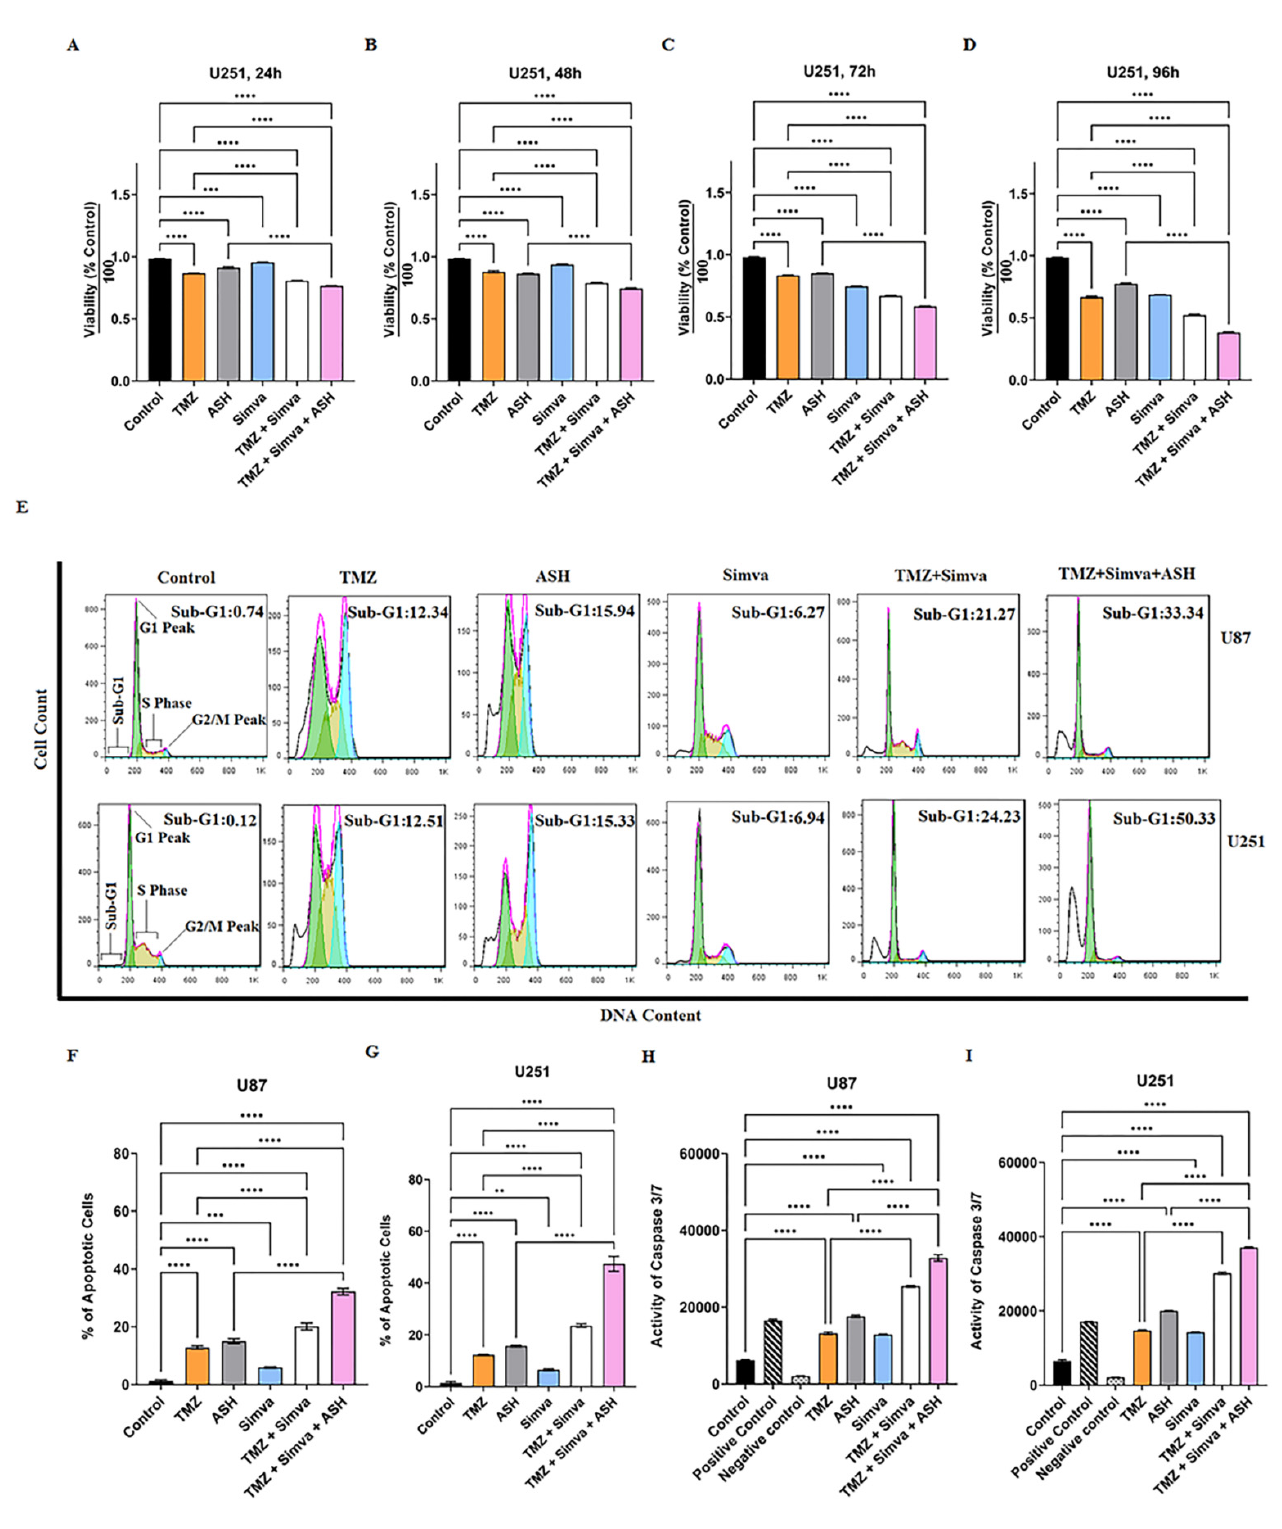
Figure 2. Simvastatin, temozolomide, acetylshikonin and their combination treatments induce significant apoptotic cell death in human glioblastoma cells. U251 cells were treated with TMZ 100 μ M, points. Cell viability was measured using an MTT assay and compared to the time-match vehicle control. Both combinations induced a significant decrease in the cell viability compared to TMZ at all time points (**** = p < 0.0001). The cytotoxicity of TMZ/Simva/ASH was significantly higher